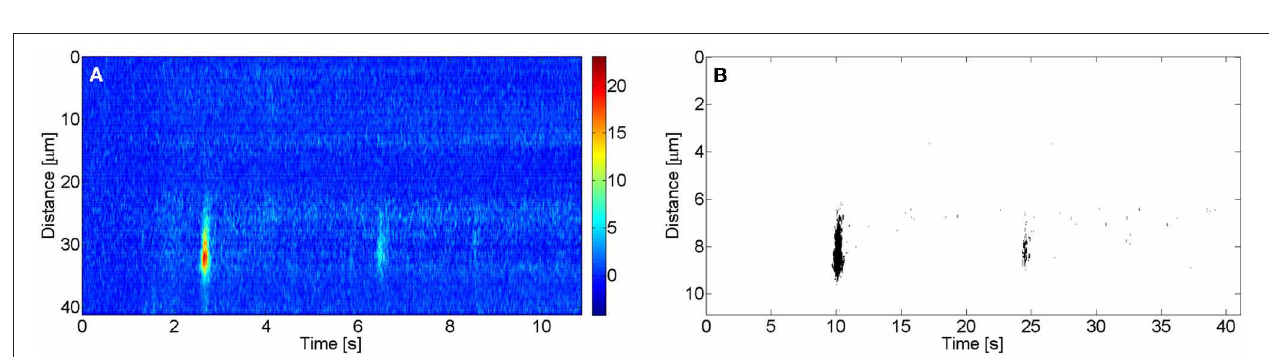
FIGURE 1 | Linescan image with two puffs in the same site. (A) (cid:2) F / F 0 fluorescence image with the corresponding color code. (B) (cid:2) F / F 0 thresholded binary image.